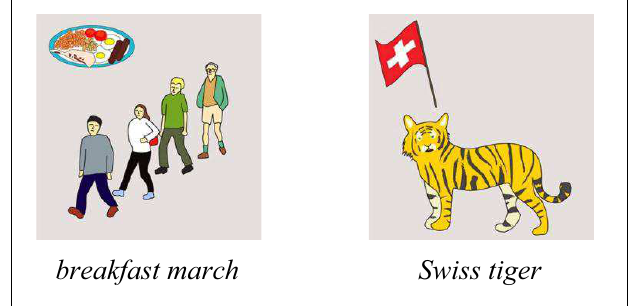
FIGURE 1 | Examples of the landmark pictograms used in the spontaneous speech map